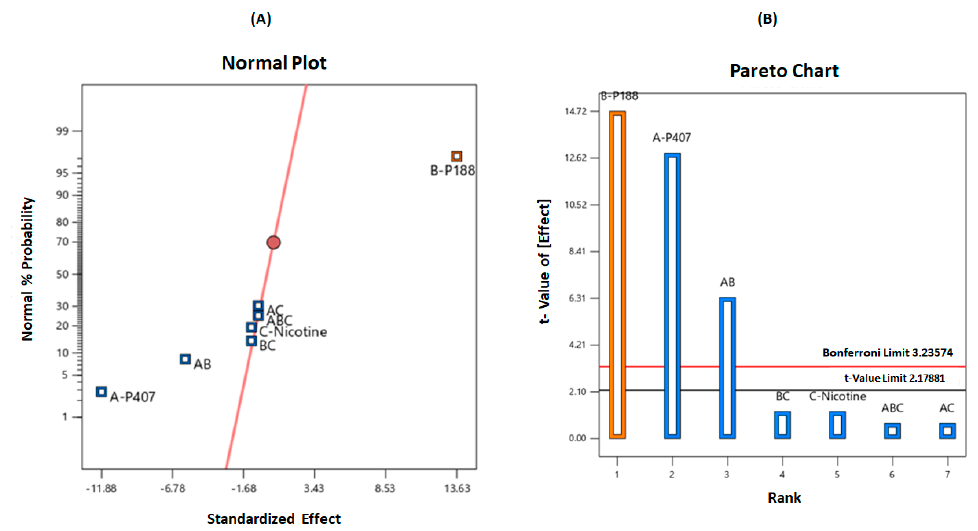
Figure 3. ( A ) Normal probability plot and ( B ) Pareto chart illustrating the significant variables on gelation temperature.